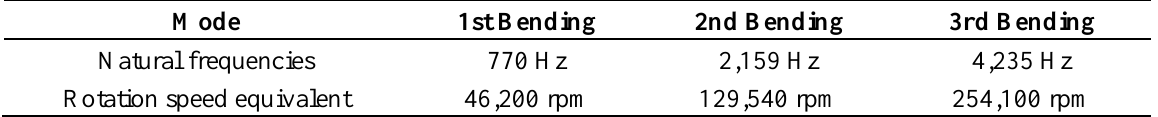
Table 2. Natural frequencies of circular shaft.